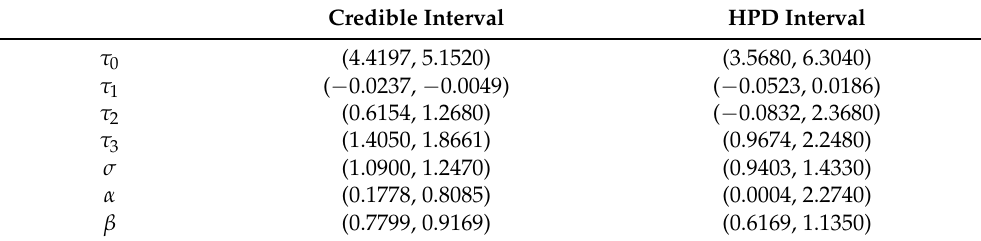
Table 6. Credible and HPD intervals of the parameters τ 0 , τ 1 , τ 2 , τ 3 , σ , α and β for heart trans- plant